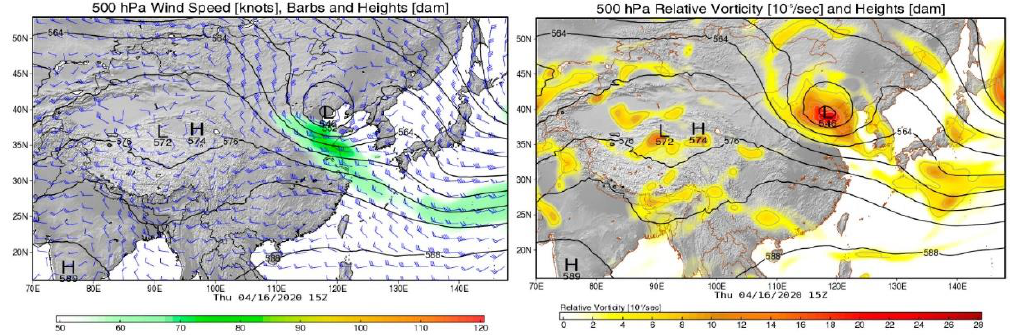
Figure A2. Daily evolution of fine aerosol optical thickness in East Asia during events 1 – 4 (event 1: a , b ; event 2: c , d ; event 3: e – h ; event 4: i – l ).